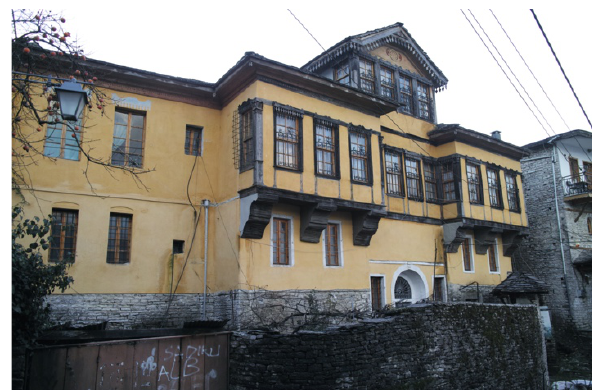
Figure 6. Main façade of Fico house (© M. Carta).